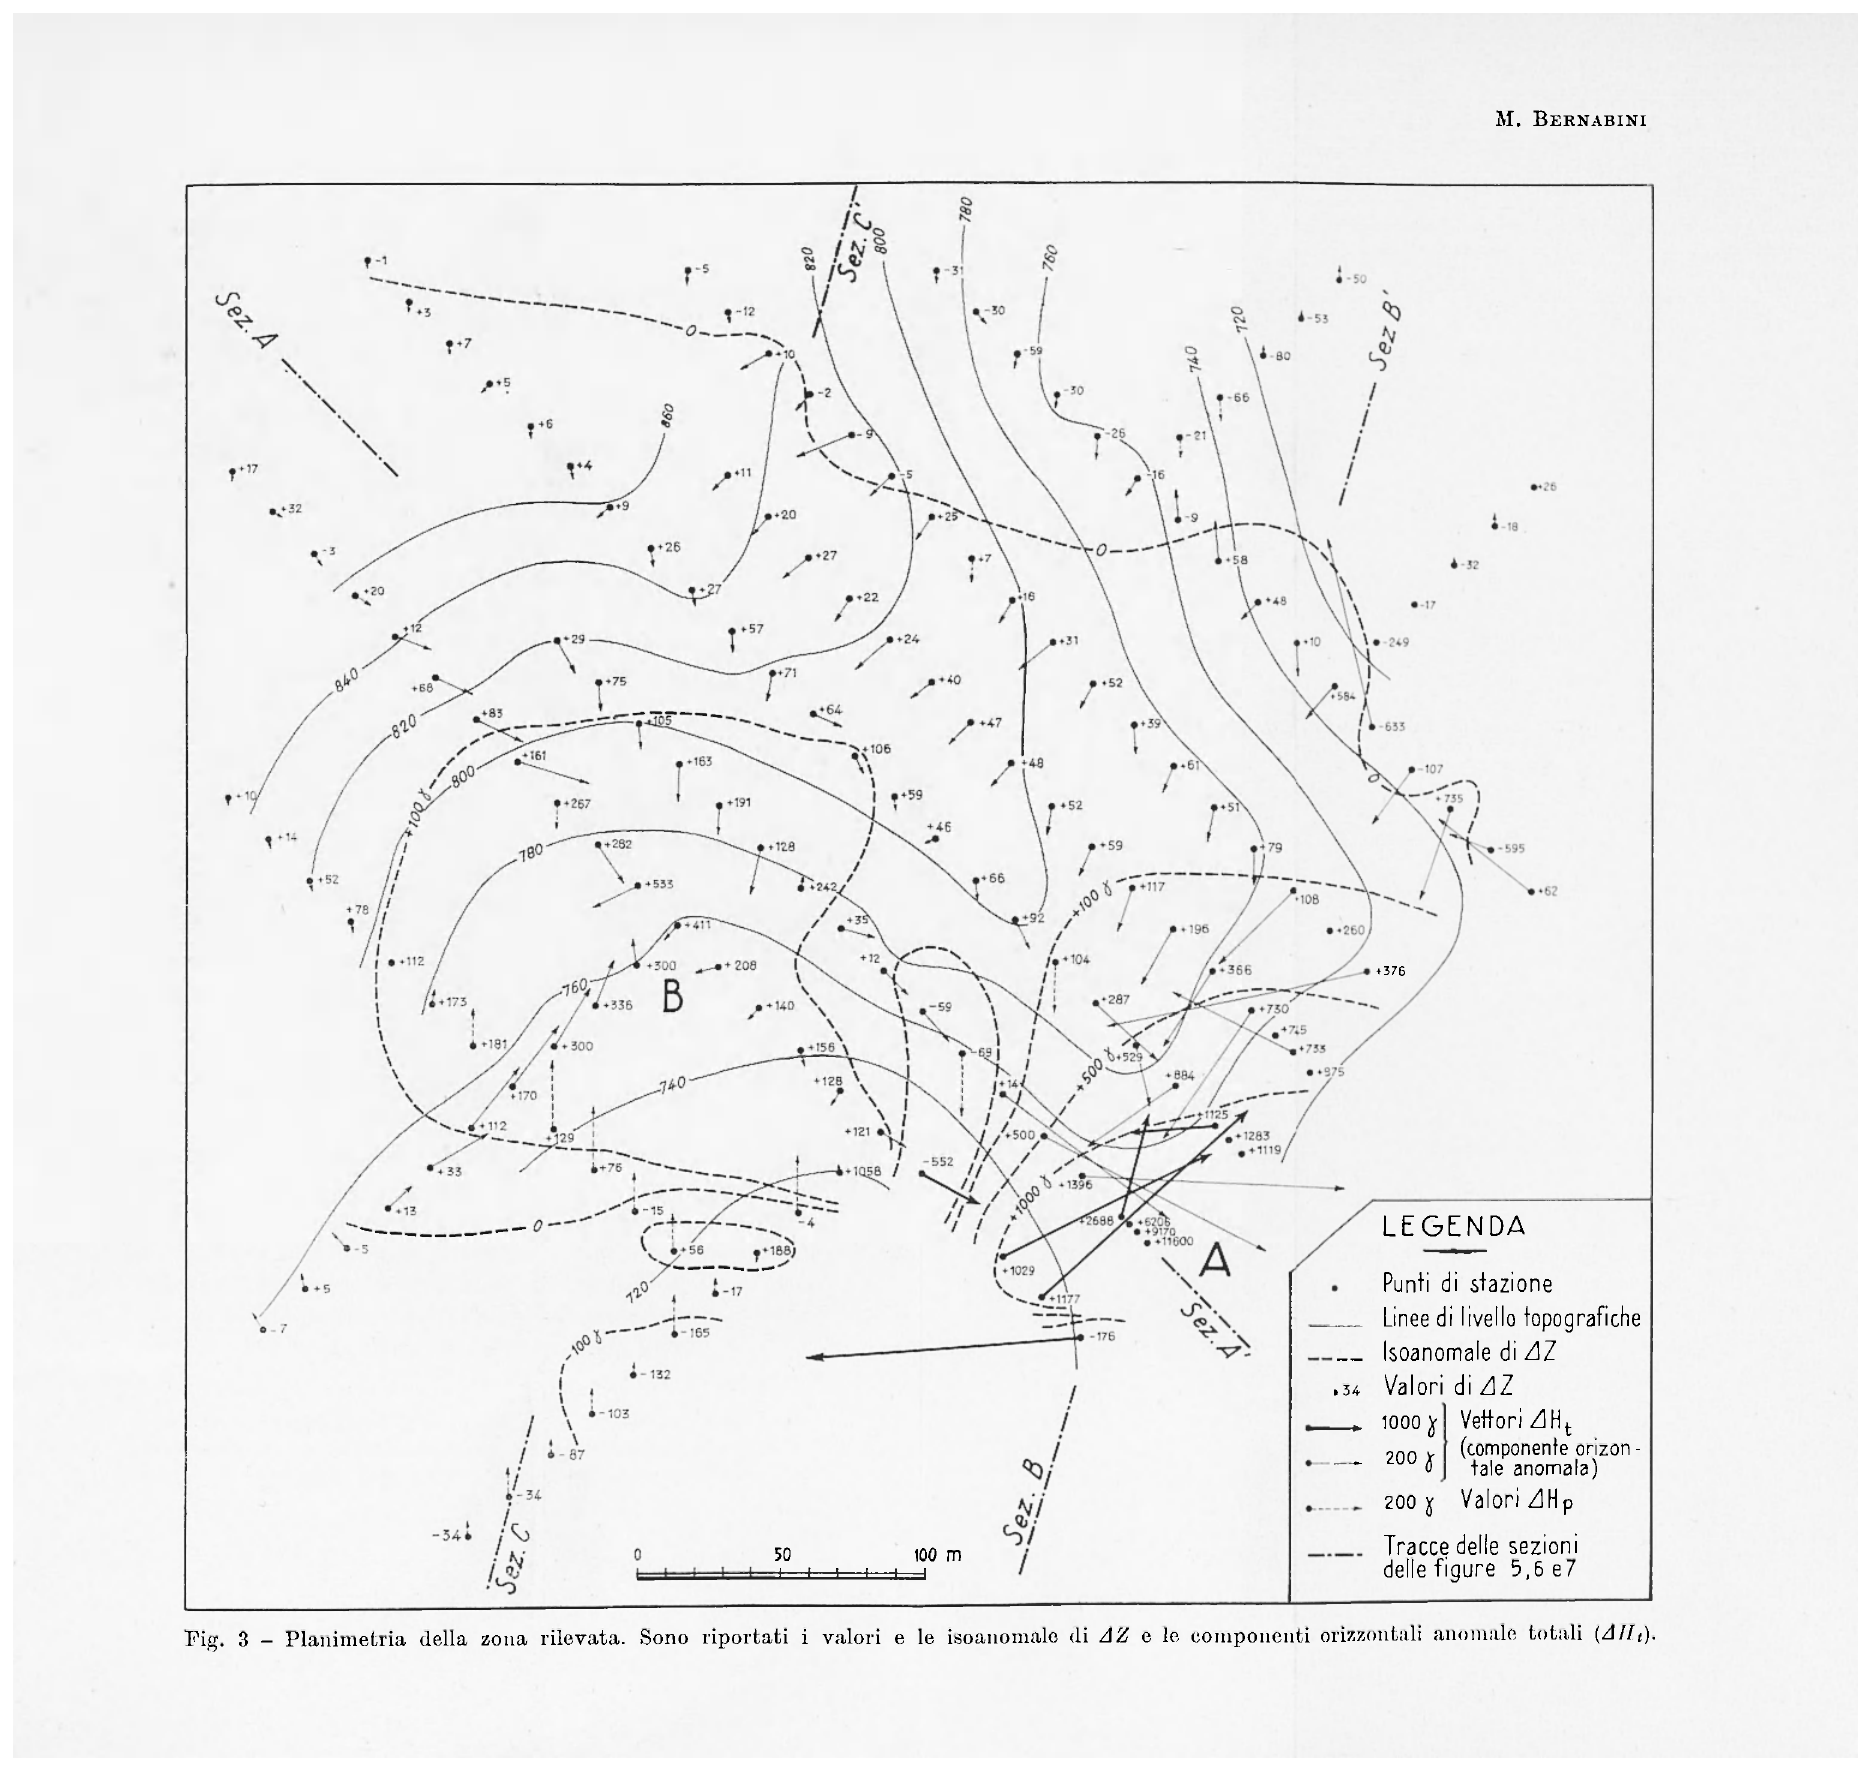
Fig. 3 - Planimetria della zona rilevata. Sono riportati i valori e le isoanomale di AZ e le componenti orizzontali anomale totali